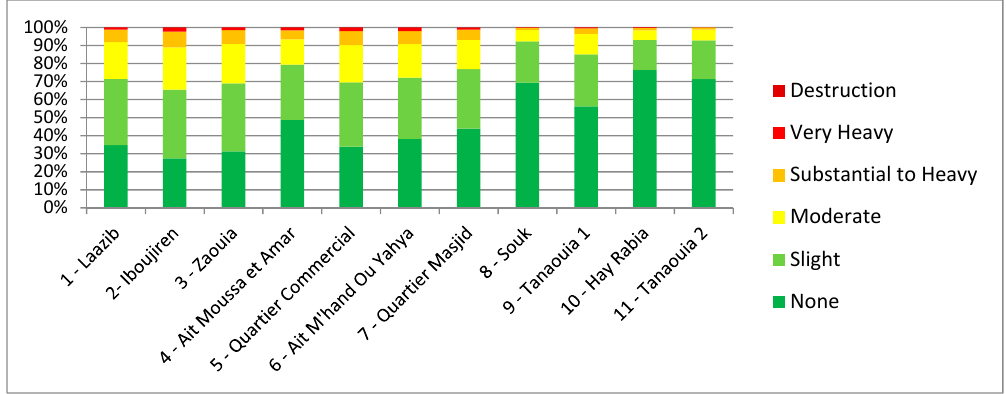
Figure 10. Damage distribution by districts according to the deterministic hazard scenario.